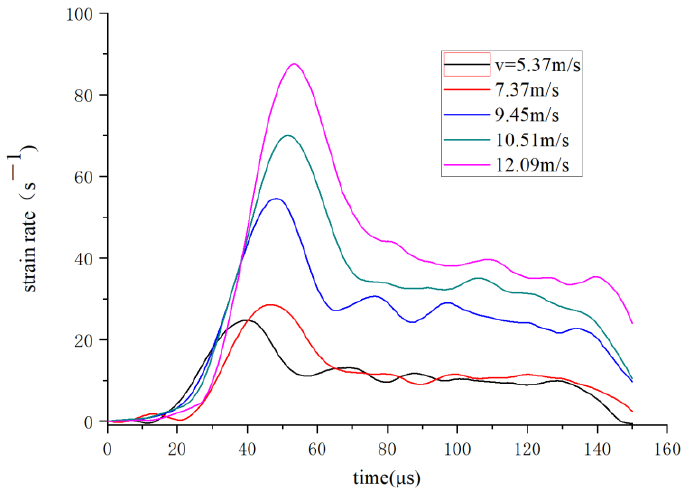
Figure 4. Strain rate – time curve .